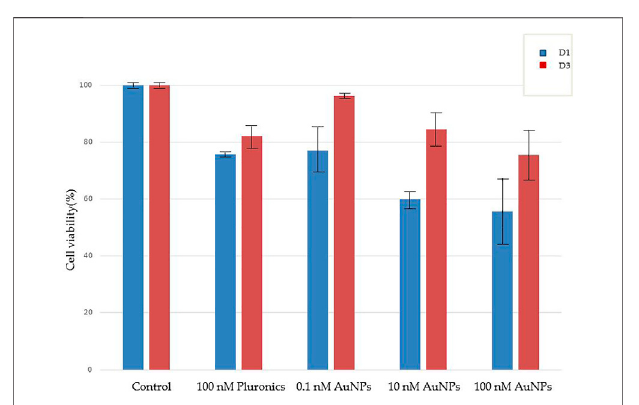
FIGURE 6 | TEM image of IB115 cells 3 days after AuNPs exposure.